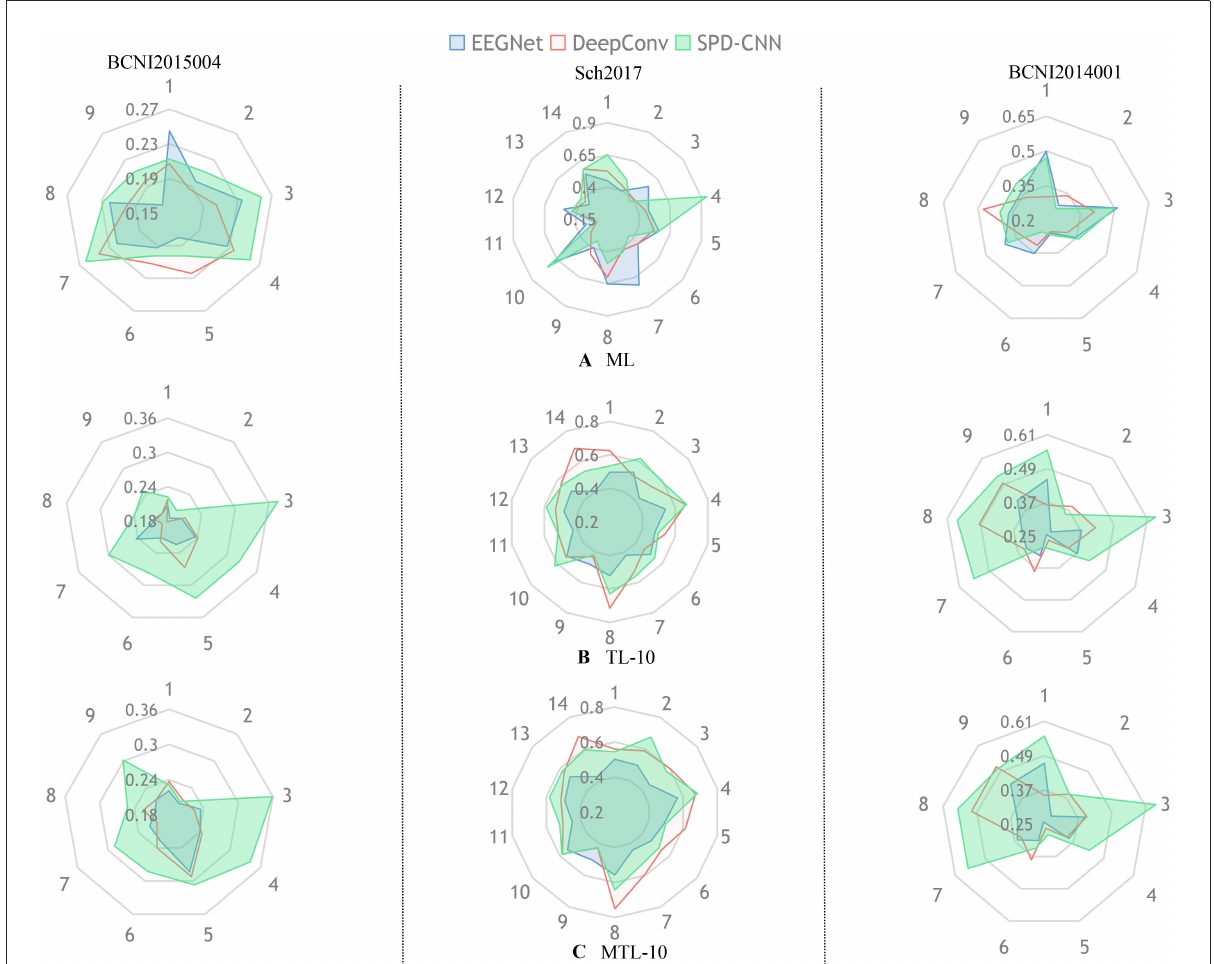
FIGURE4 In each radar picture, every axis is assigned a variable that represents the classification accuracy of the specific subject (such as 1:subject1 and 2:subject2) and the different colors represent different network architectures (Blue:EEGNet,Red:DeepConvNet,Green:SPD-CNN).Also, the radar pictures arranged in the same column are shown the performance of experiences in the same dataset. The subgraph (A) represents the experiments that train the network with the ML method using zero-shot in the target domain. The subgraphs (B,C) represent the experiments that train the network with TL and MTL methods, respectively and fine-tune the network using 10shot on the target